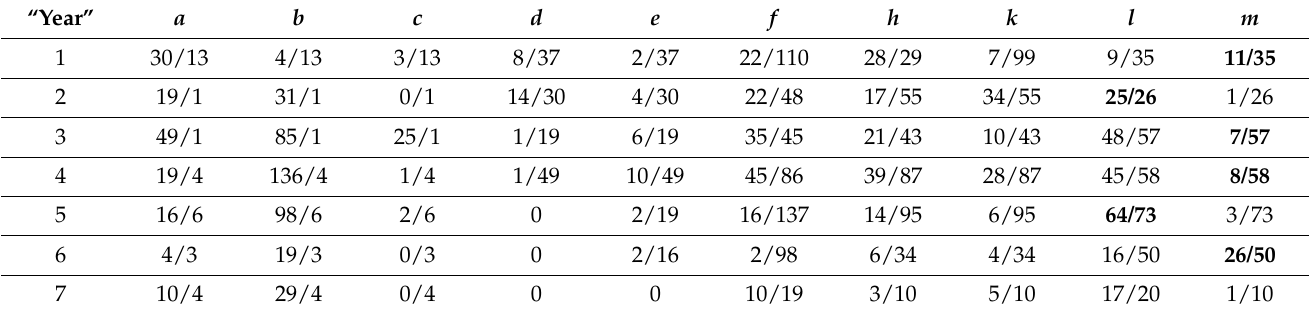
Table 2. Example 2 : modified Example 1 for testing the column substochastic property.